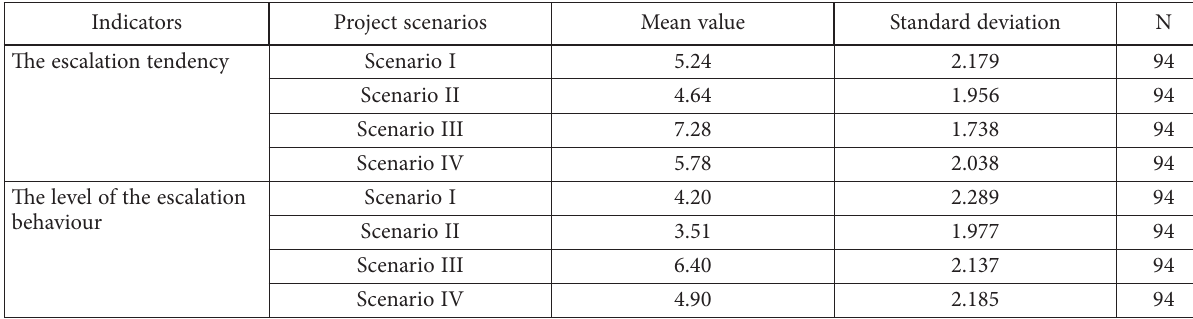
Table 2. Descriptive statistics of EOC by investors